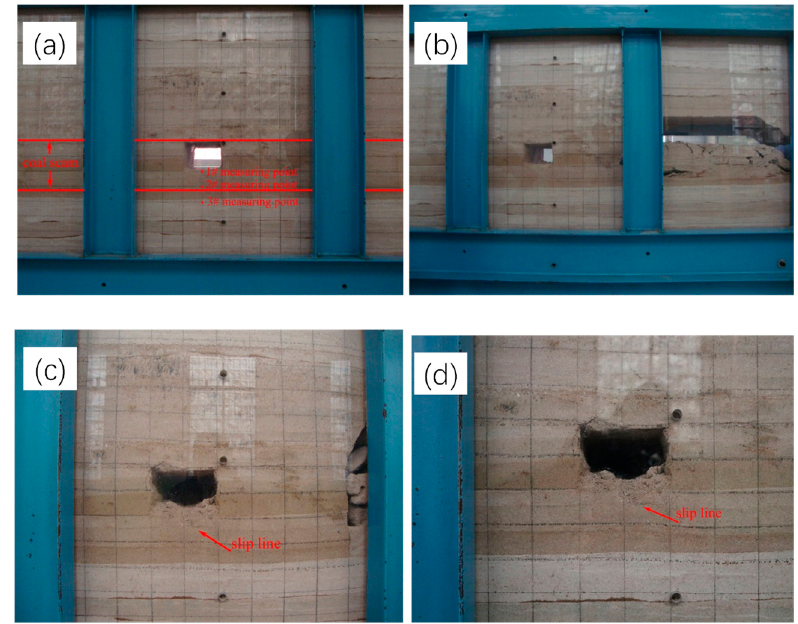
Figure 8. Deformation and failure of the entry floor under di ff erent width coal pillars. ( a ) Similar simulation model; ( b ) coal pillar of 12 m wide; ( c ) coal pillar of 10 m wide; ( d ) coal pillar of 6 m wide.